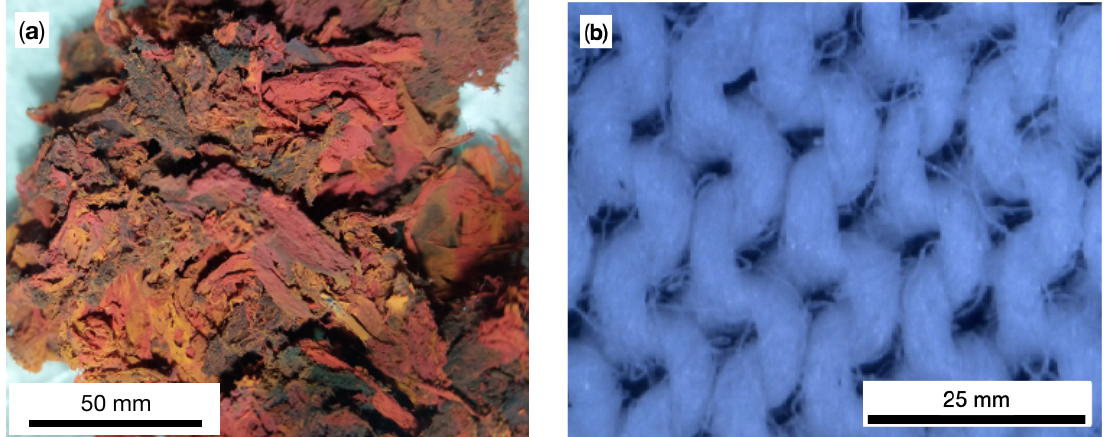
Figure 1. (Color online) ( a ) Image of µ F. ( b ) Cotton fibers at 1000 ×